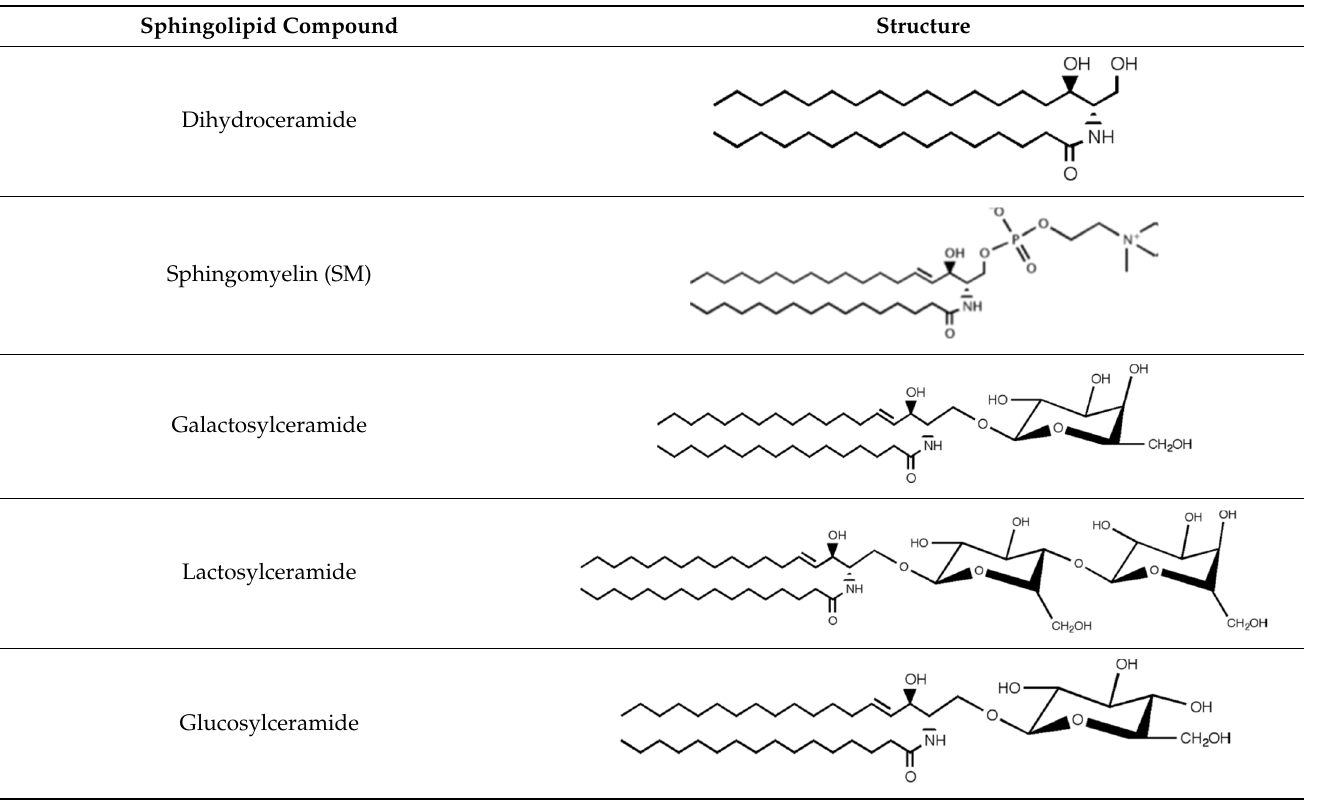
7 Table 2. Main sphingolipids present in human cells and their structures [21]. Sphingolipid Compound Structure Ceramide (Cer) Sphingosine 1-phosphate (S1P)